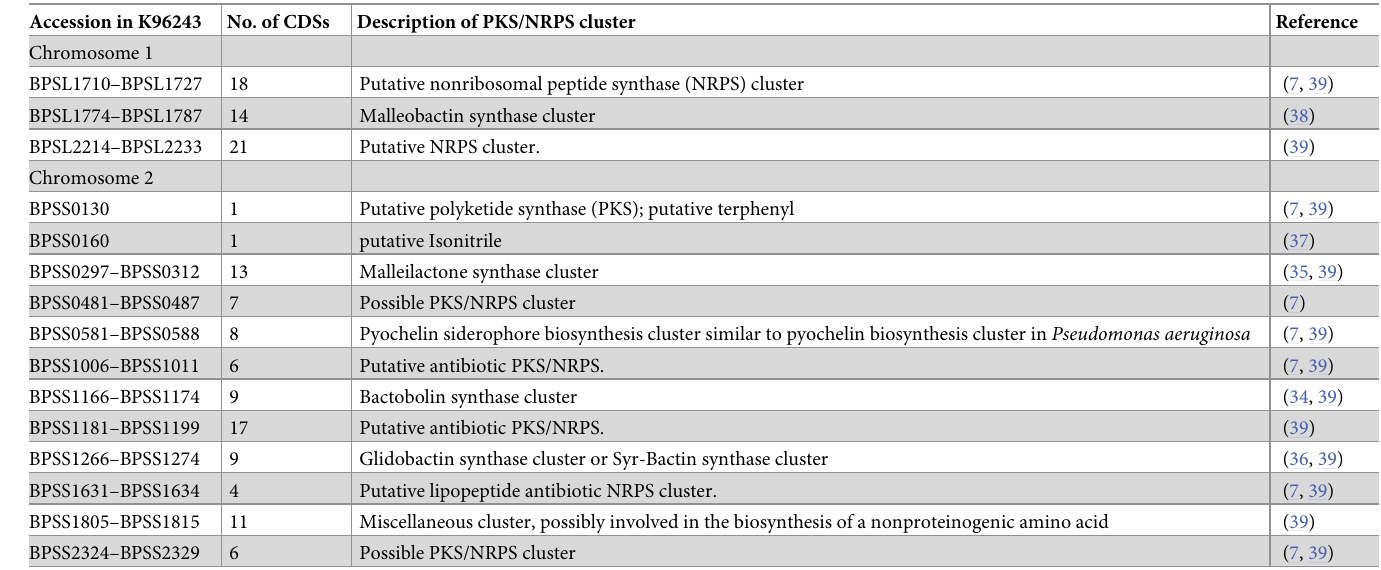
Table 2. Analyzed PKS/NRPS clusters for putative expression based on expressed proteins.